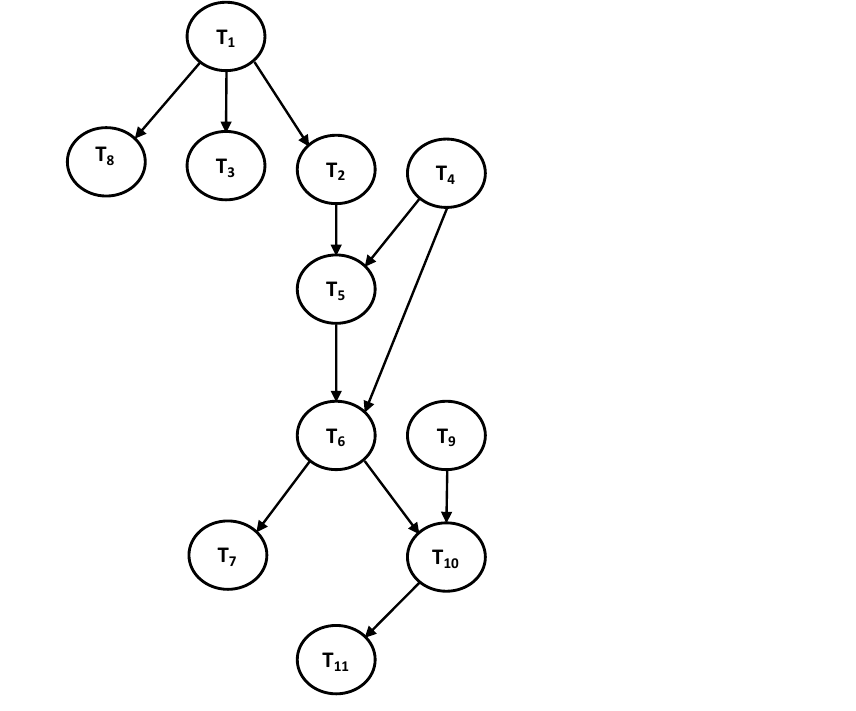
Figure 2. Described local dependency graphs for MSFN x .